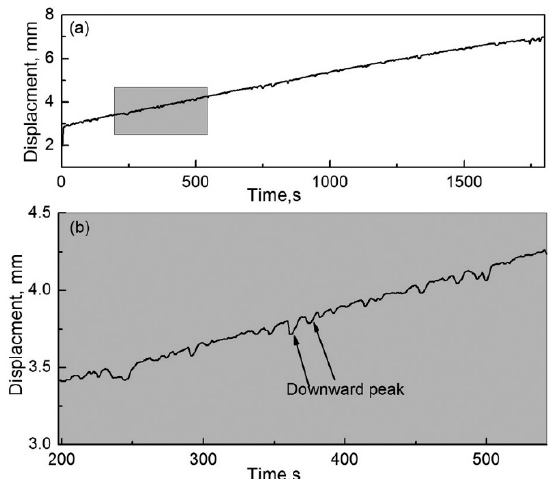
Figure 11 Pin-displacement evolution during friction when the RD was used; H = 26.1 × 10 3 A/m. ( a ) Complete drawing and ( b ) local enlarged drawing of the shadowed region in (a).